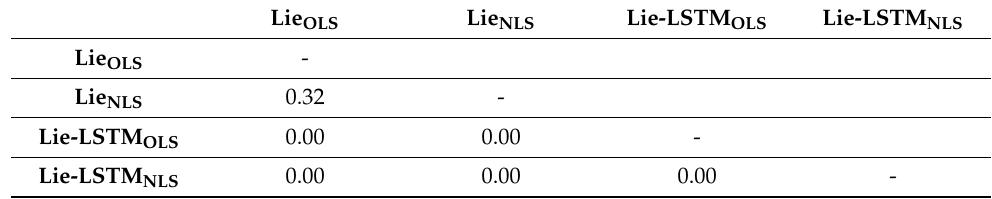
Table 8. p -values for the Diebold–Mariano